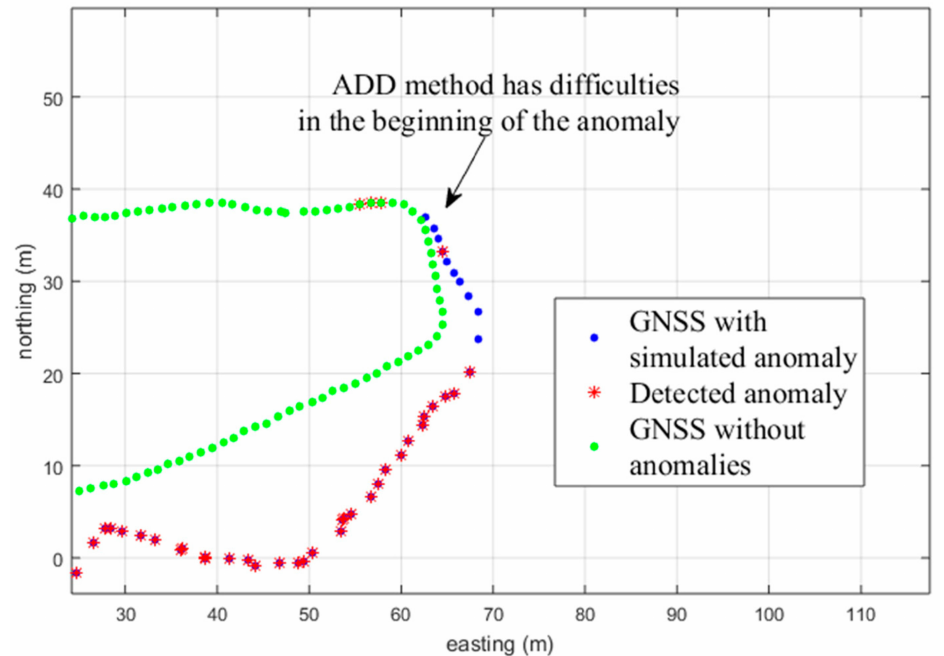
Figure 8. The green track shows the original good-quality GNSS track. The blue track is the GNSS track with the simulated anomalies and the red bullets indicate a detection by the method used (ADD).